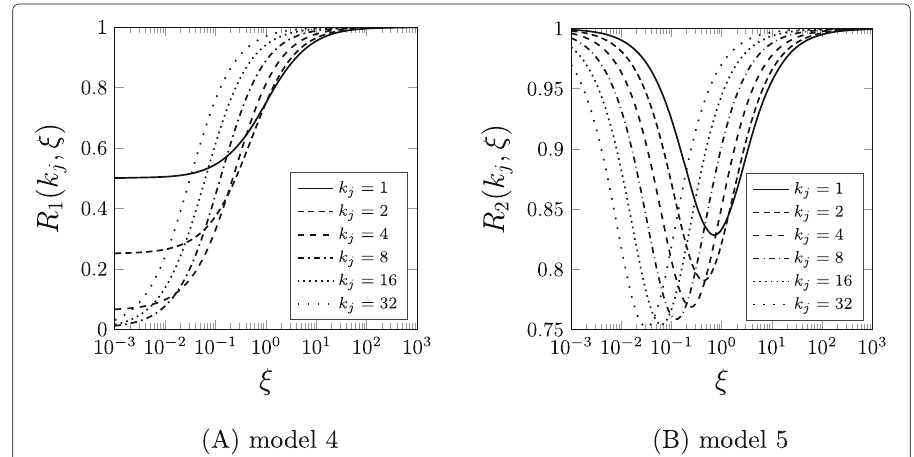
Fig. 3 Mean resting times with respect to model 6. Going from model (1) to (4) to (5) to (6), the mean resting time is increasing - all dynamical and topological parameters being equally chosen, and diffusion on, say, a tree topology would be slower. Ratios R 1 and R 2 of Eqs. 34 and (35) allow to compare the former three models with two timescales (corresponding to μ and λ = η ), for which there is walker-edges interaction. It measures the reduction in mean resting times of walks (Mod. 4) and (Mod. 5) with respect to the additive model 6. Observe that only the degree and ξ = λ μ determine these comparisons. That R i ( k j , ξ → ∞ ) = 1 for i = 1,2 and R 2 ( k j ,0 ) = 1 is explained by the asymptotic behaviour described in Fig. 4. Also observe the different , when k j → ∞ , whereas R 1 approaches zero ranges of values for R 1 and R 2 . The smallest value of R 2 is above 3 4